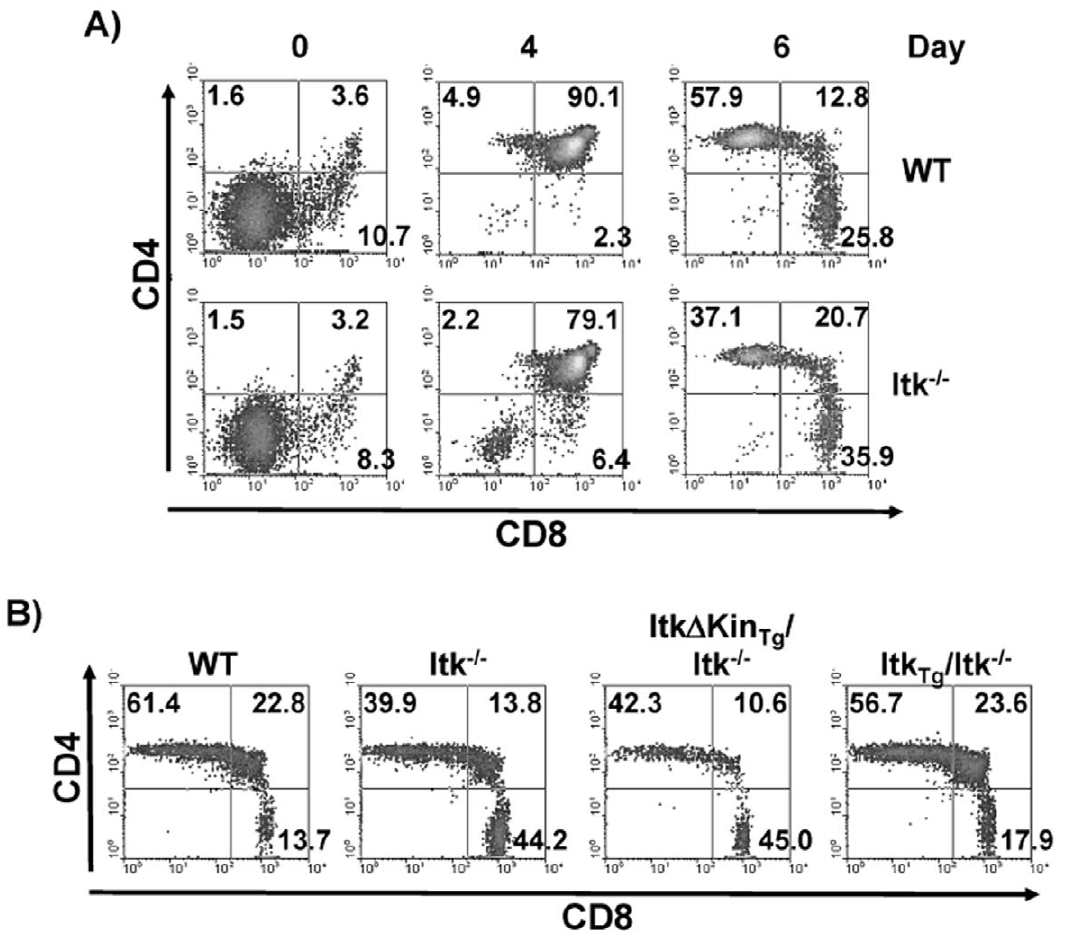
Figure 2. (A) Fetal Thymic Organ Culture analysis of WT and Itk 2 / 2 thymocyte development. FTOC from embryonic day 16 of WT and Itk null mice incubated in vitro for the indicated days, gated on TCR hi and analyzed for CD4 and CD8 (data representative of 3–4 mice). (B) Active Itk kinase activity is required for T cell development. Thymocytes from WT, Itk 2 / 2 , Tg(Lck-Itk D Kin)Itk 2 / 2 and Tg(CD2-Itk tg )Itk 2 / 2 mice were gated first on the TCR hi and analyzed for expression of CD4 and CD8.